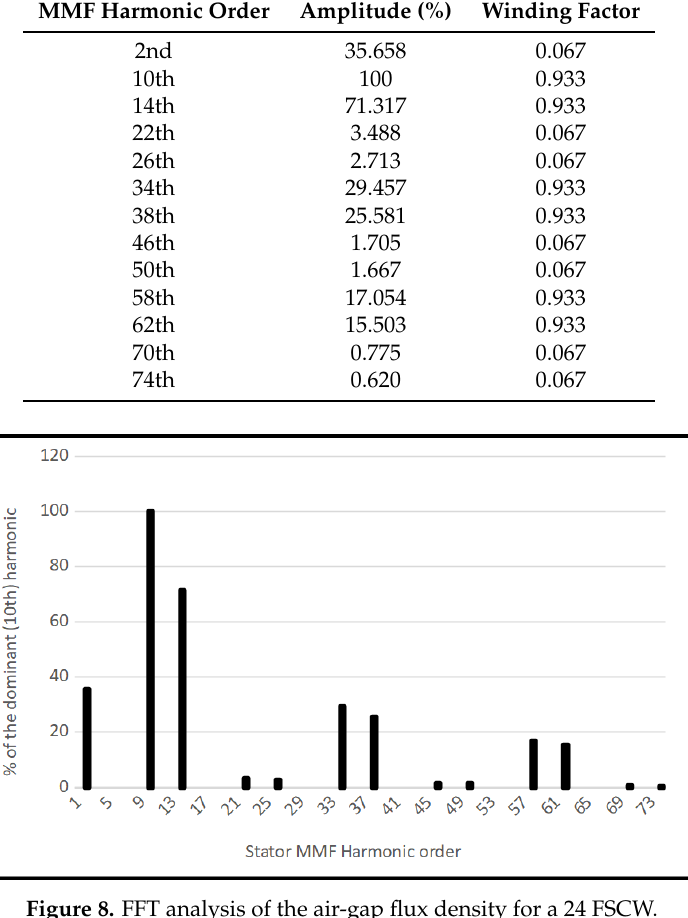
Figure 8. FFT analysis of the air-gap flux density for a 24